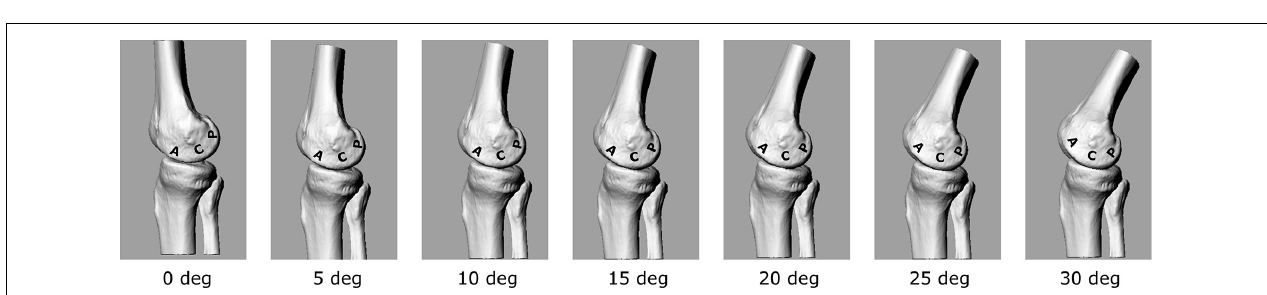
FIGURE 4 | 3D representation of the tibio-femoral joint at different knee flexion angles (0 ◦ –30 ◦ ). A different cartilage region (Posterior, Central, Anterior) is loaded at each flexion